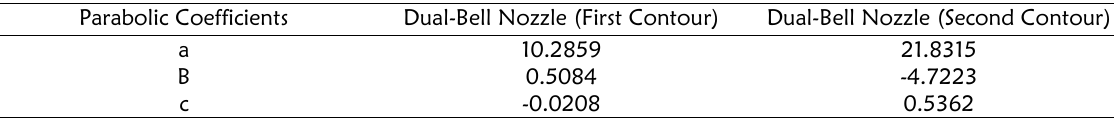
Table 1: Parabolic coefficients of the dual-bell nozzle